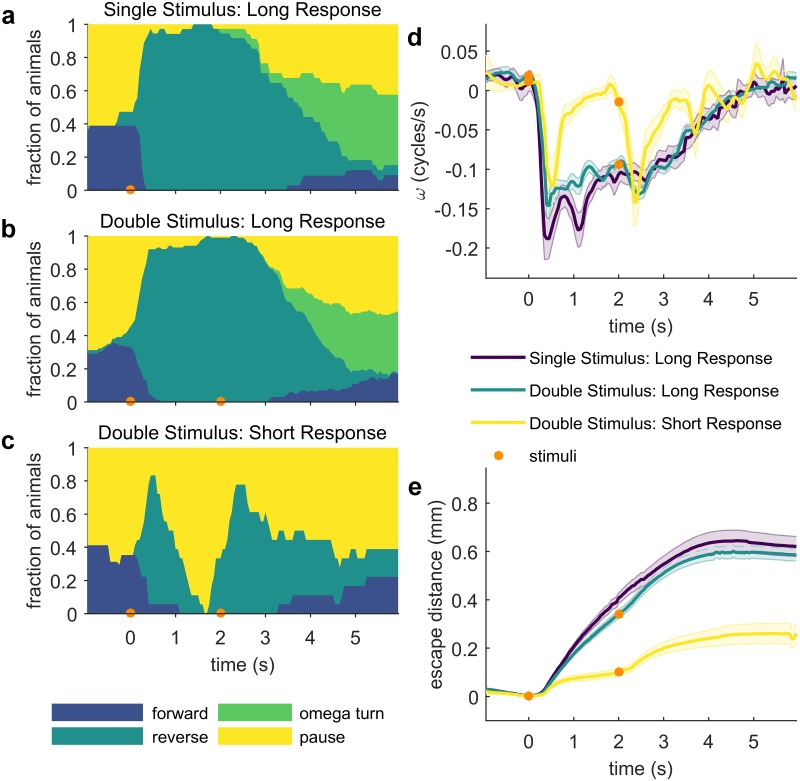
Initiation of the escape response is suppressed while an escape reversal is still underway.(a-c) Fraction of animals occupying each behavioral state in response to either a single (a) or double (b and c) thermal stimulus, separated by 2 s (133 ms 95 mA, focused by 100 mm lens). Only animals that respond to the first stimulus with a reversal are included. The SHORT and LONG responding animals are separated on the basis of the behavioral state occupied prior to the second stimulus, at 2 s after the first stimulus. Animals that have stopped reversing and transitioned into a paused state are categorized as SHORT response, while animals that are still reversing are labelled LONG. Note the similarity in the behavioral state distribution over time after the second stimulus between the single- (a) and double-stimulated (b) LONG responders. Stimuli timing is indicated with orange circles. Single stimulus n ≥ 32; double stimulus LONG n ≥ 74; double stimulus SHORT n ≥ 14. (d) Average phase velocity of worms in each of the three populations in (a-c). Shaded regions indicate the standard error of the mean. Note the robust response to the second stimulus from the SHORT responding population (d, yellow); also visible in (c). (e) Mean escape distance for each of the three populations in (a-c). Shaded regions indicate the standard error of the mean. Full ethograms shown in S5 Fig.